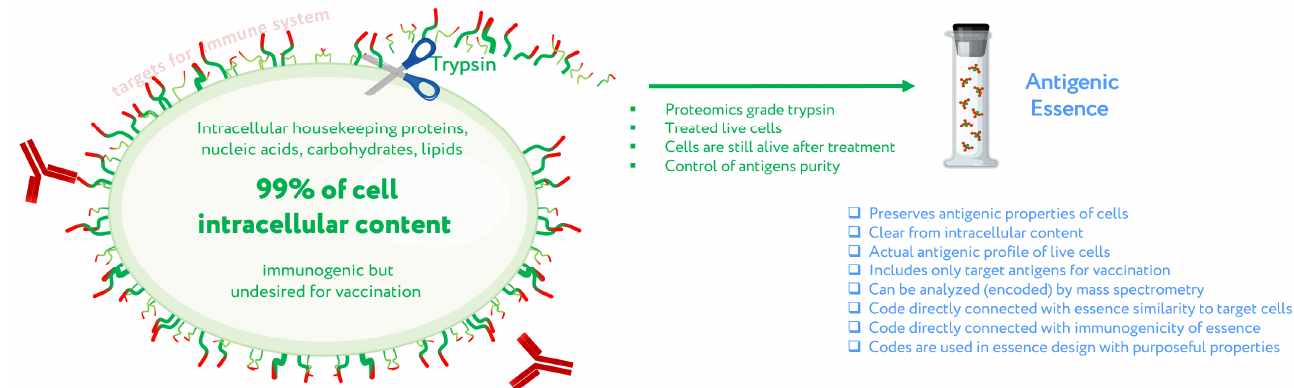
Figure 2. Concept of antigenic essence. Actual antigenic properties of live cells are defined by a pool of antigens presented on the cell surface. Intracellular content is considered noise to be excluded from the essence. After washing away traces of culture medium, cells are treated with a purified protease. Released fragments of the cell surface proteins are collected, analyzed by mass spectrometry, and used for vaccination instead of whole cells. Adapted from [29].